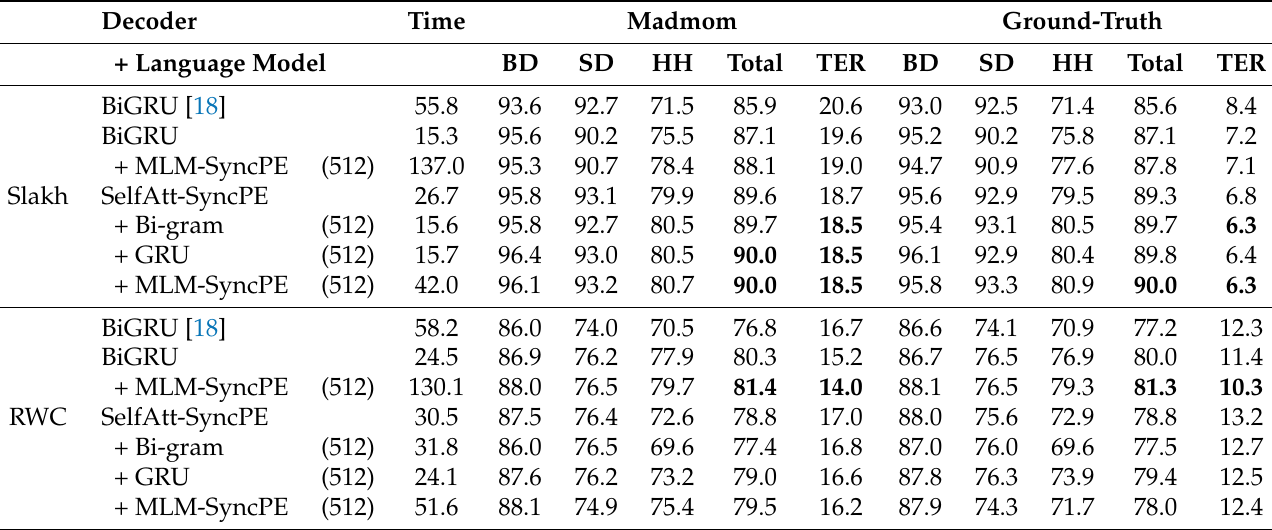
Table 6. Training times per song (s/song), F-measures (%), and TERs obtained by the conventional and proposed methods. Decoder